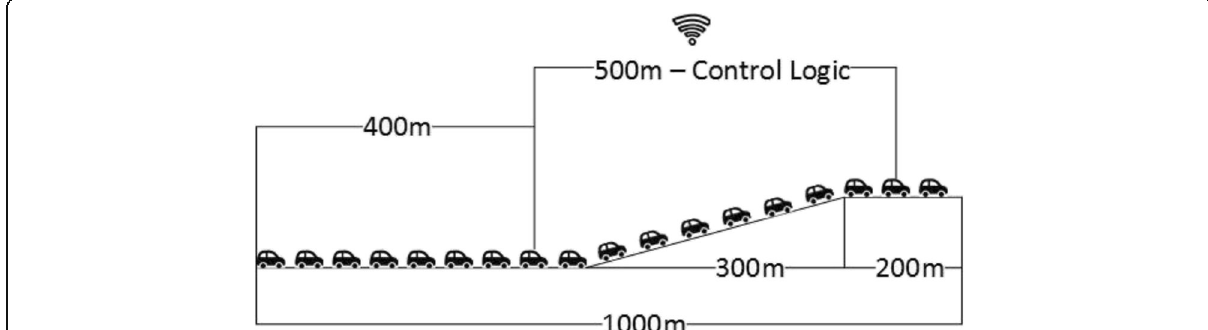
Fig. 2 One-lane network, 1 km long with an uphill segment of 300 m. In the figure, it is shown also the area where the control logic is